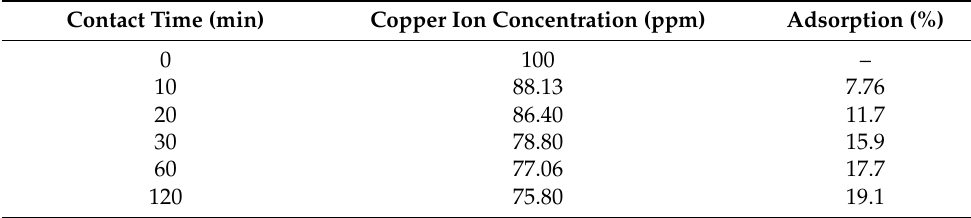
Table 2. Adsorption of copper onto PEI-CS/PCL_60s